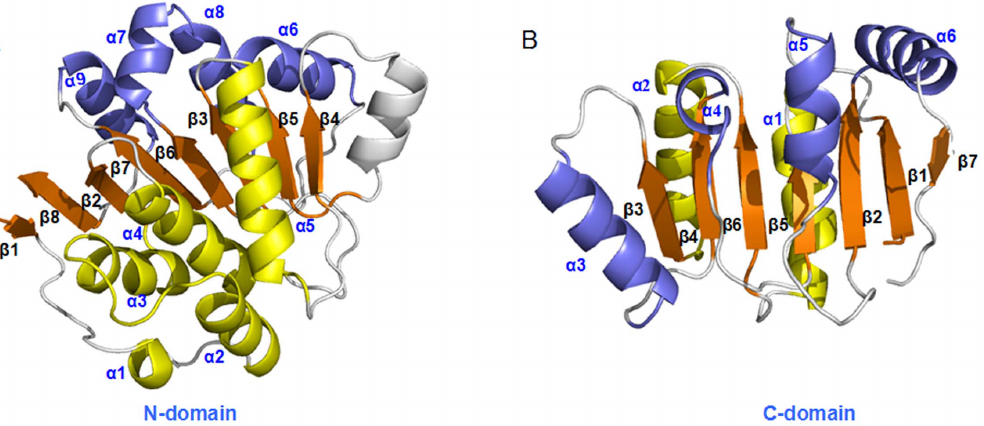
Figure 4. The structures of N- and C- domains of eIF4A. The structures of (A) the N-domain 5 a (yellow) - 8 b (orange) - 4 a (slate) and (B) the C- domain 2 a (yellow) - 7 b (orange) - 4 a (slate) for the eIF4A